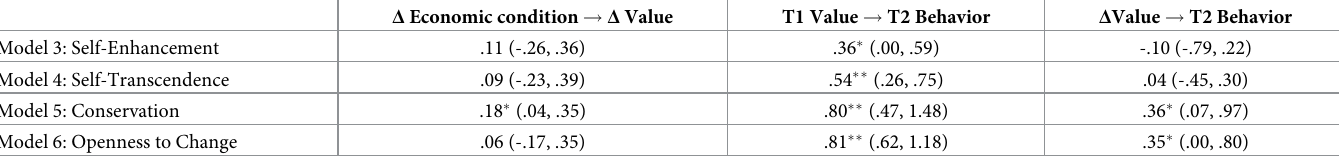
Table 5. Parameter estimates (standardized regression coefficients) for univariate conditional LCS